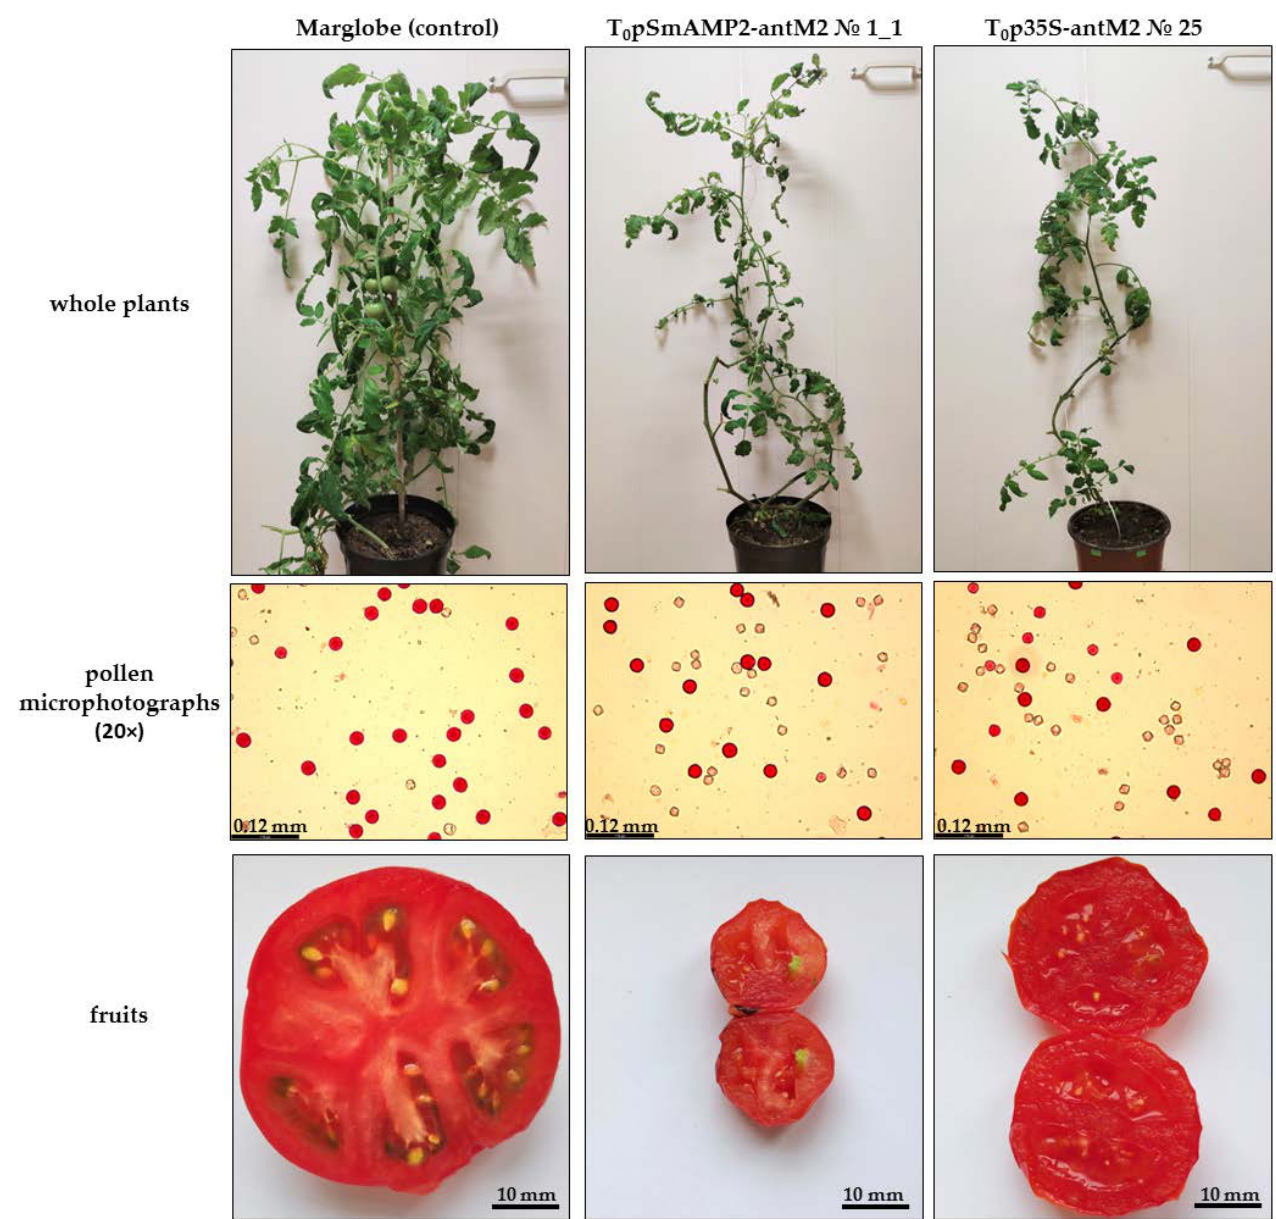
Figure 5. The morphology of several examples of MSH2-RNAi plants under “long-day” (16 h light/8 h dark)